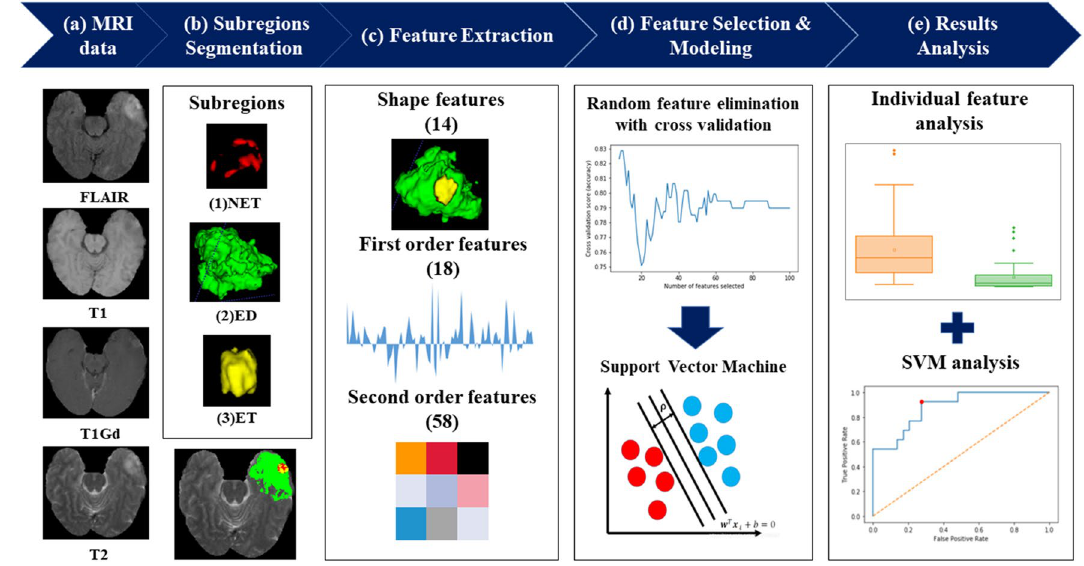
Fig. 1 Subregion-based radiomic analysis for predicting glioma grade. a MRI data acquisition. b Tumor subregion segmentation. c Feature extraction. d Feature selection and model construction. e Results